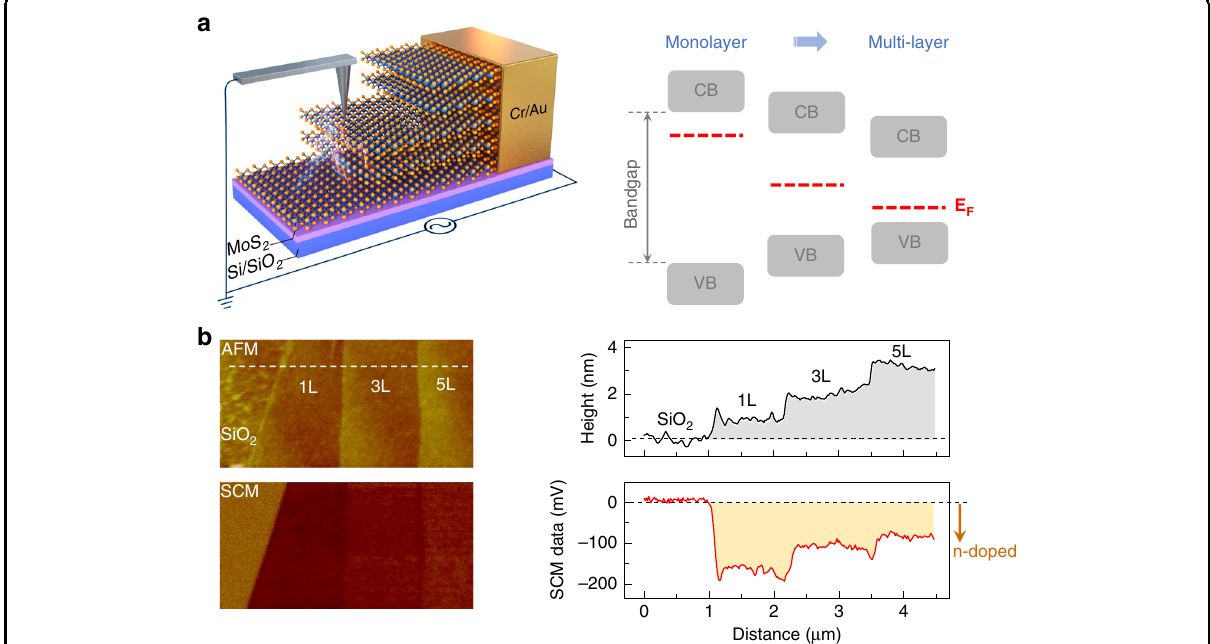
Fig. 1 SCM experiment on vdW layered material. a Left panel: schematic showing the experimental setup. The sample preparation consists of mechanical exfoliation (of layered materials), electron-beam lithography and metal-contact evaporation (~60 nm Au/Cr) processes. During the measurements, the sample is powered by a 1 V 90 kHz ac bias and a conductive probe (kept virtual ground) was used to retract the localized differential capacitance signal while scanning over the device area. Right panel: evolution of the background doping characteristic of MoS 2 with an increasing thickness. b AFM and SCM images of a stair-like MoS 2 fl ake, including 1L, 3L and 5L segments. The pro fi les are derived along the white dashed line. All the SCM experiments were performed in nitrogen